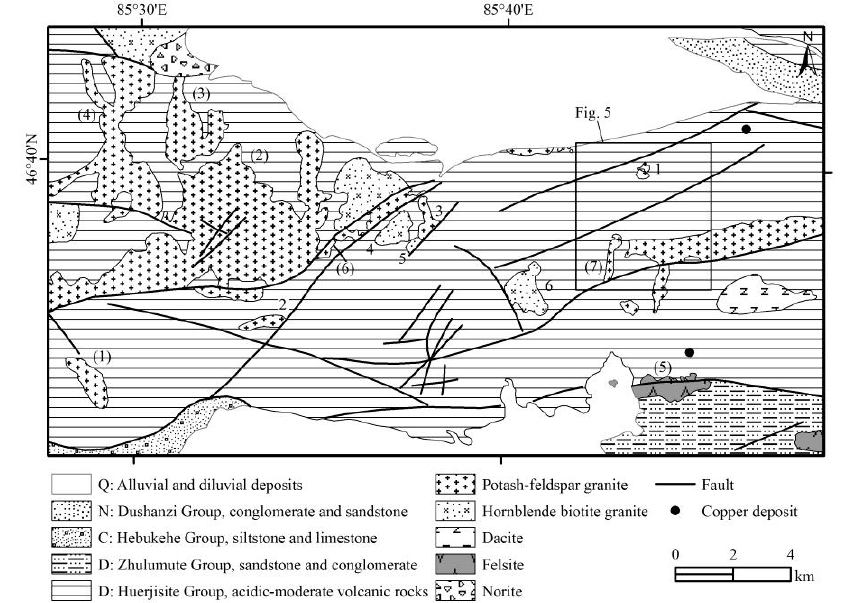
Figure 4. Geologic map of Xiemisitai modified after integrating the results of remote sensing data with two internally published geologic maps and field inspection data (The differences from the original geological maps (Figure 1(b)) and on the basis of image interpretation (Figures 2 and 3) and ground confirmation are here labeled with 1–6 and (1)–(7), however, some may not be clear due to the scale reduction here). Q, Quaternary; N, Neogene; C, Carboniferous; D,